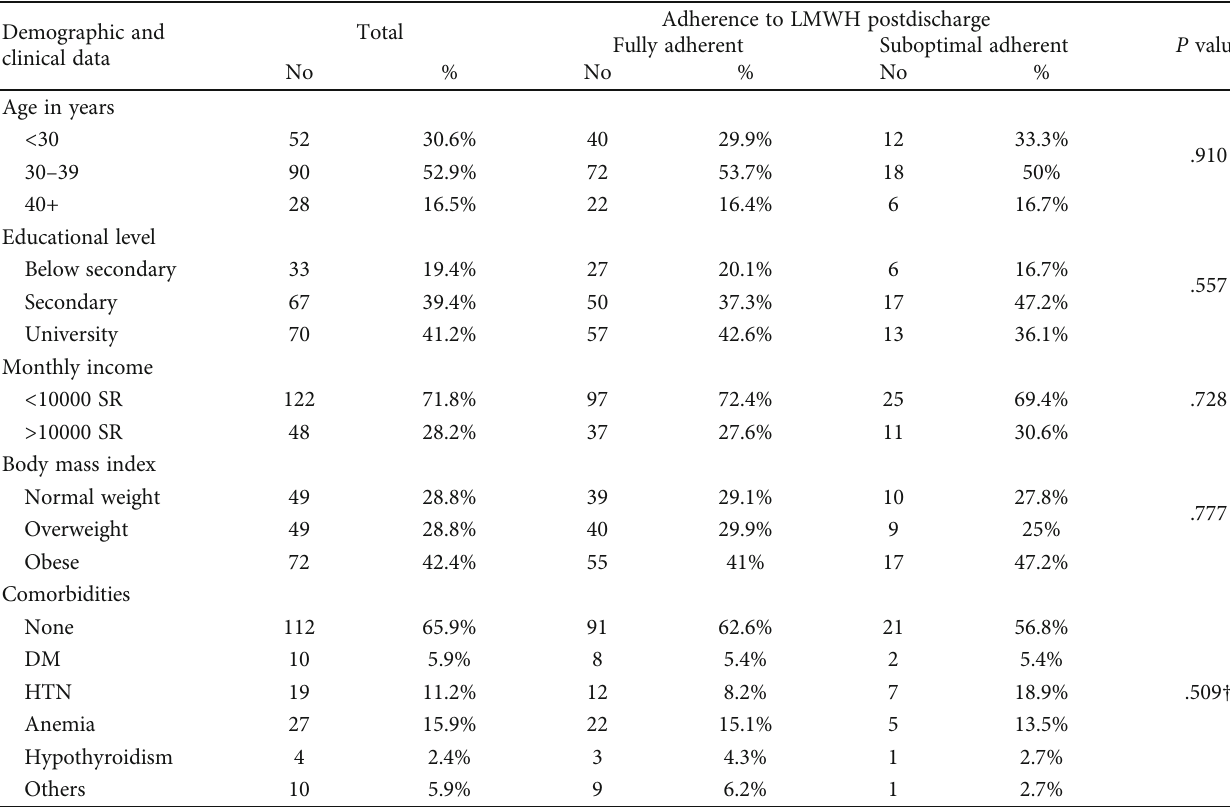
Table 3: The distribution of parturients ’ adherence to LMWH postdischarge after cesarean delivery by their demographic and clinical data. Demographic